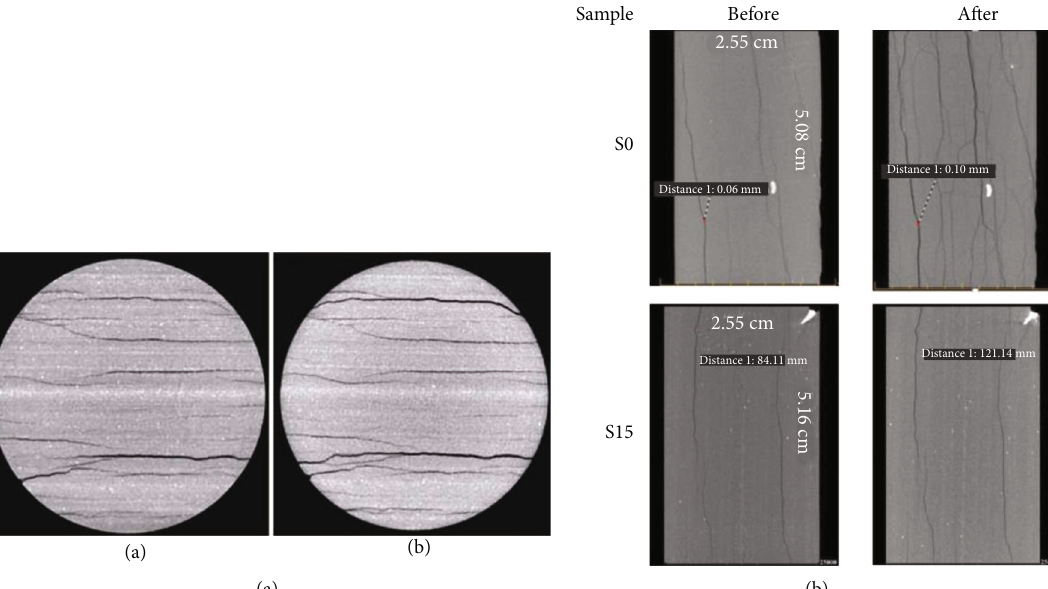
Figure 7: (a) Fracture generated and propagated in Bin et al. ’ s [76] tests. (b) Fracture generated and propagated in Wang et al. ’ s [25] tests.